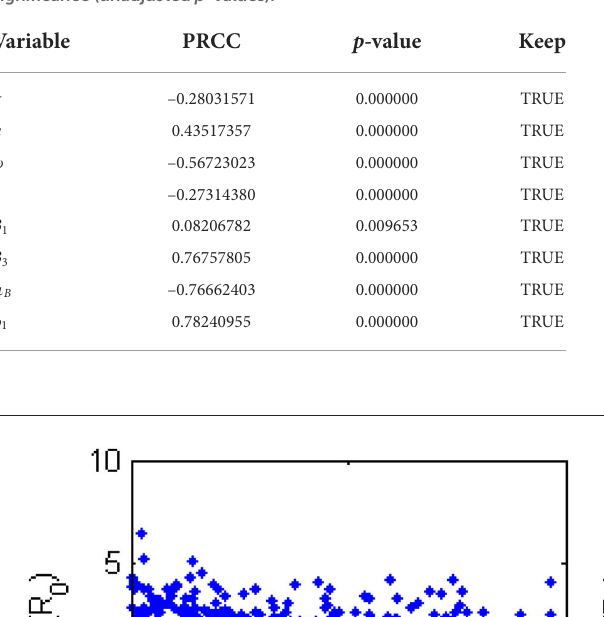
TABLE 3 Parameter partial rank correlation coefficient (PRCC) significance (unadjusted p -values).